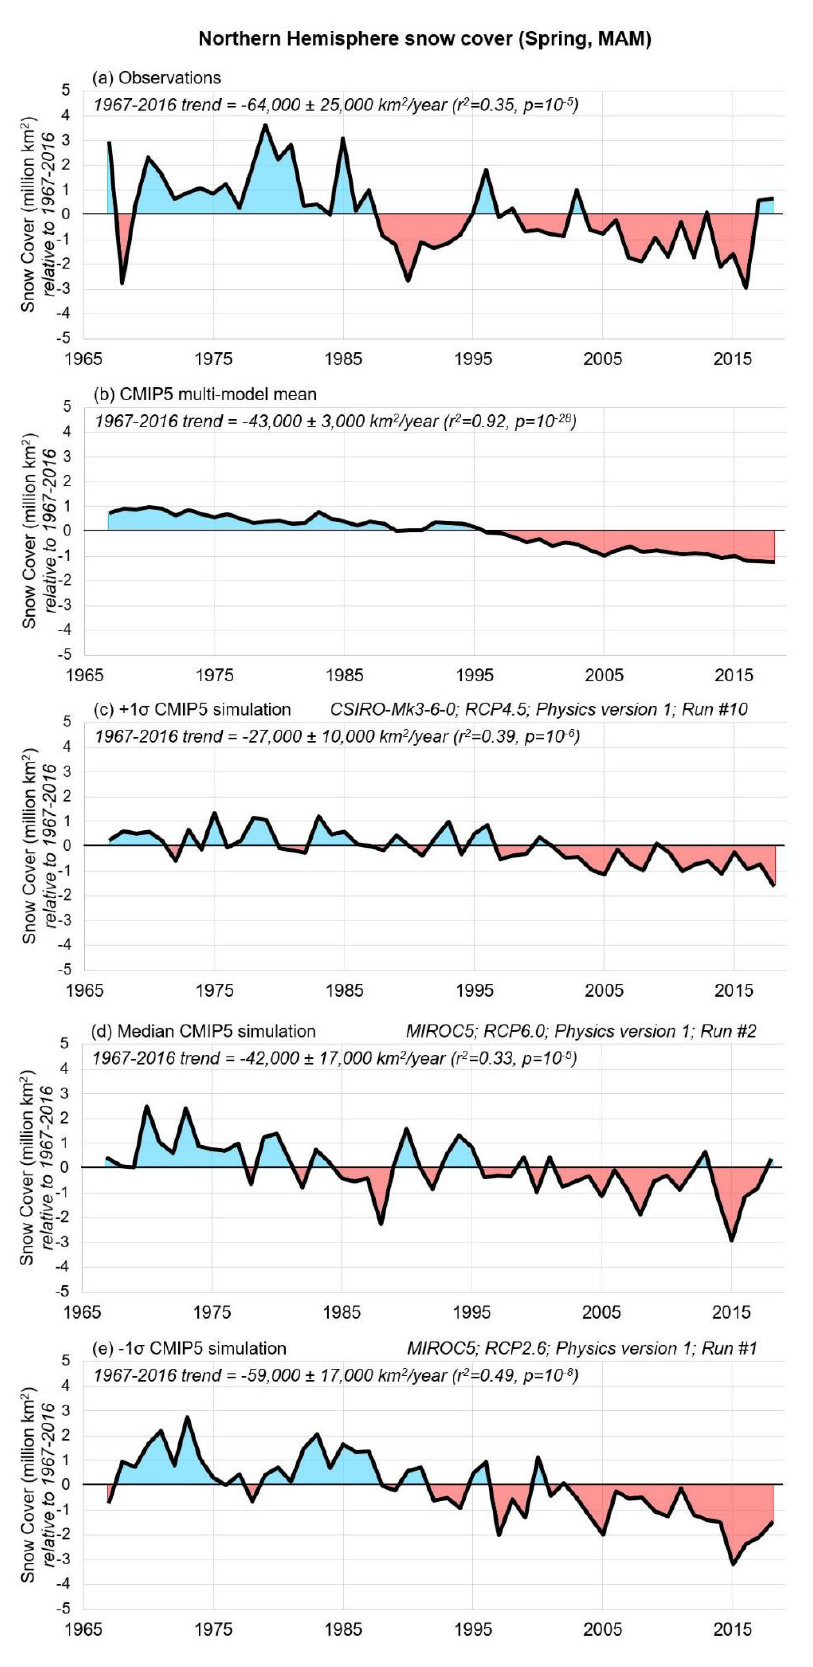
Figure 6. Same as Figure 4, except showing the spring (MAM, i.e., March, April and May).